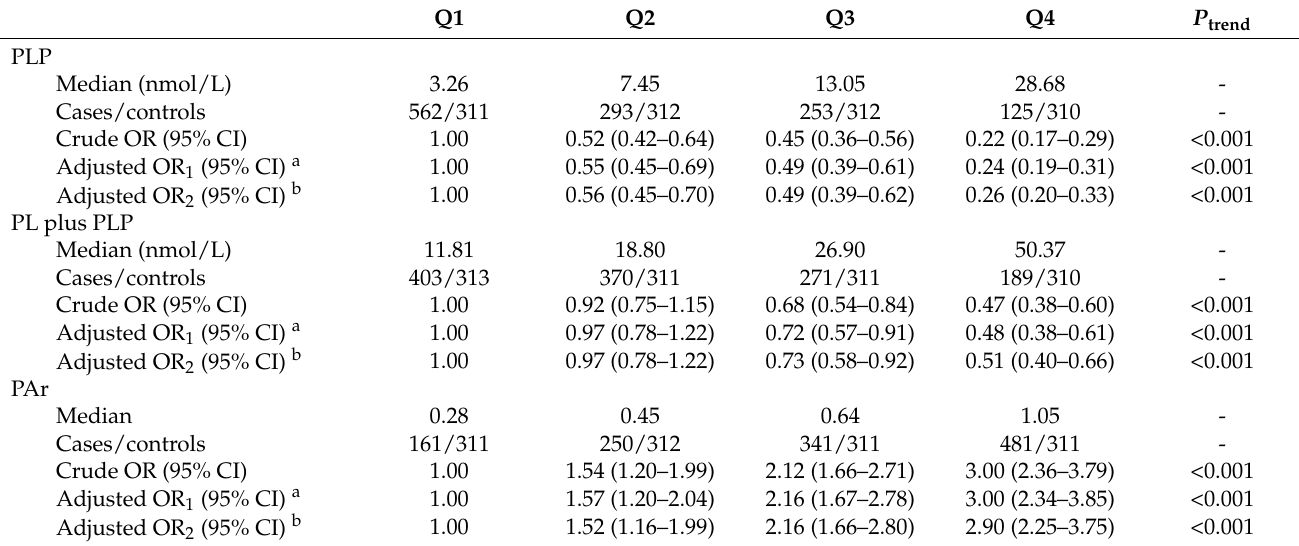
Table 3. Odds ratios (ORs) and 95% confidence intervals (95% CIs) of colorectal cancer according to quartiles of serum PLP, PL plus PLP, and PAr